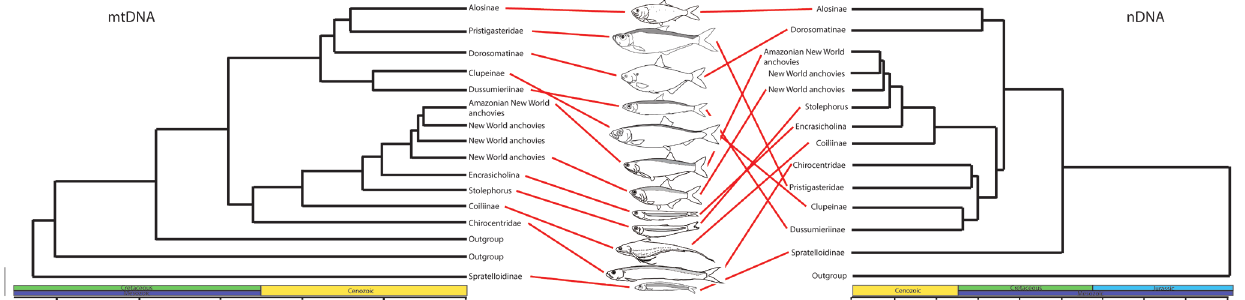
Fig. 1. Clupeiform phylogenies pruned to only show major lineages estimated using concatenated Bayesian analysis of the mtDNA dataset (left) and nDNA dataset (right) in BEAST v.2.4.5. Red lines illustrate similarities and differences in the place - ment of major lineages by mtDNA versus nDNA. Time, in millions of years, is shown along the x-axis. Line drawings depict representative species from clupeiform lineages: Brevoortia tyrannus , Ilisha elongata , Dorosoma cepedianum , Etrumeus sadina , Clupea harengus , Pterengraulis atherinoides , Cetengraulis edentulus , Encrasicholina heteroloba , Stolephorus sp . , Coilia dussumieri , Chirocentrus dorab , and Spratelloides gracilis (from top to bottom).